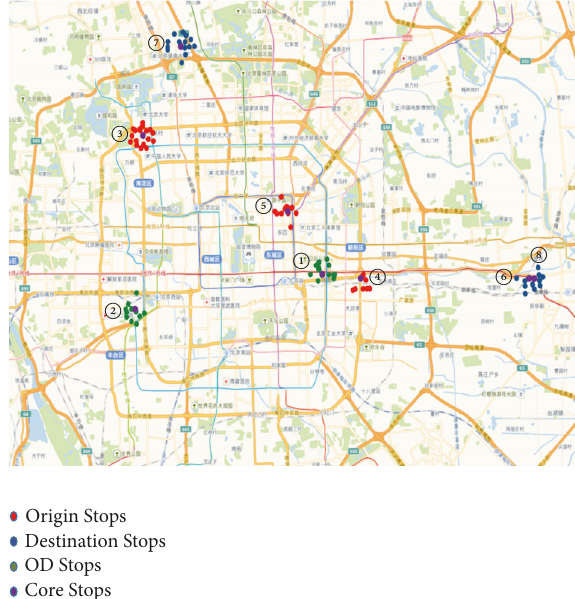
Figure 15: The top five origin area stops and the top five destination area stops with the most passengers in the